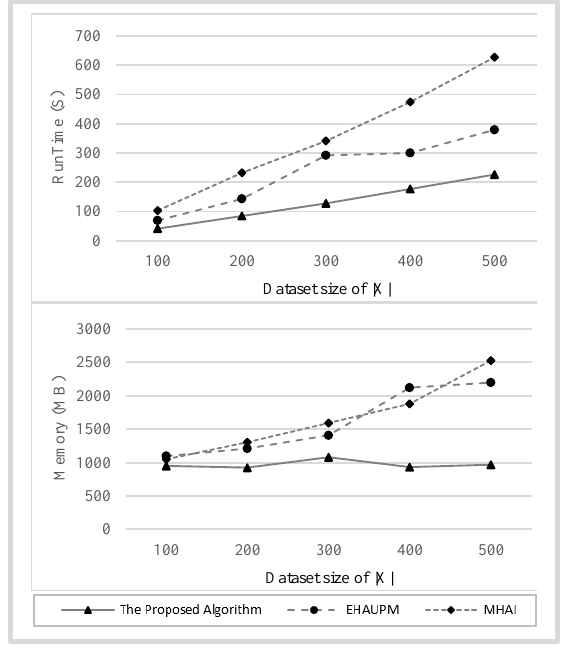
Figure 6. Runtime and memory consumption for various dataset sizes on T35 I100D |X|K.